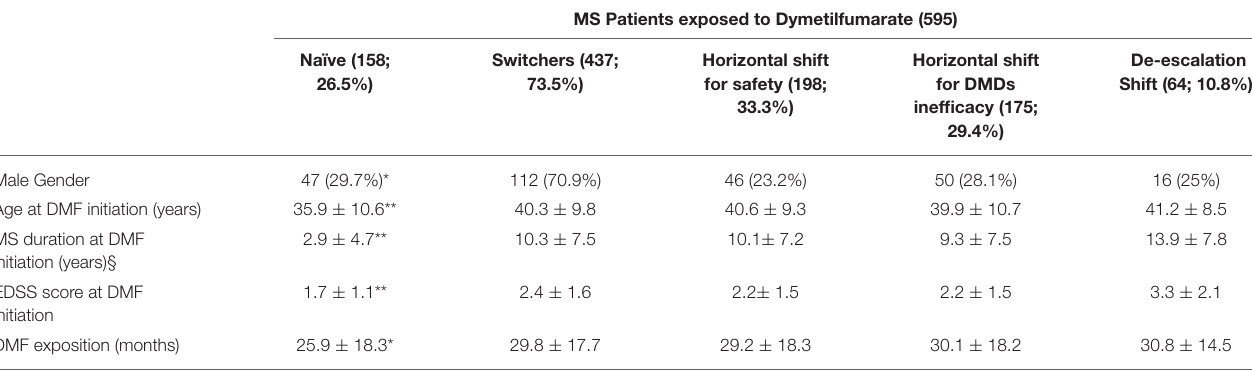
TABLE 1 | Demographic and clinical features of MS patients exposed to dimethylfumarate categorized as naive or based on the type of therapeutic shift (horizontal for safety; horizontal for DMDs ineffectiveness;